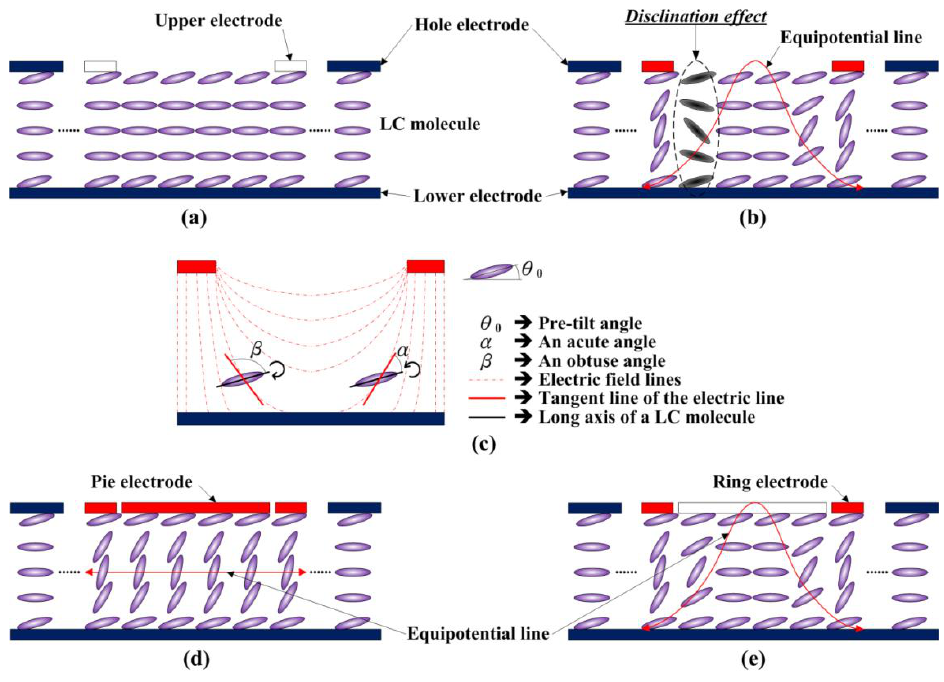
applied. (b) Disclination lines occurrence. (c) Electric fields and rotated directions of LC molecules. (d) In-plane electric field applied. (e) Disclination lines